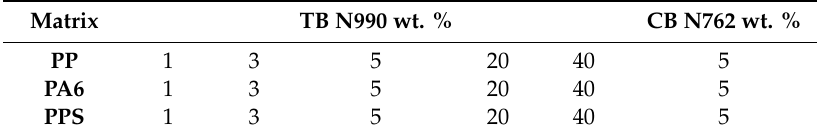
Table 1. Formulation of extruded compounds containing TB N990 and CB N762. Matrix TB N990 wt.